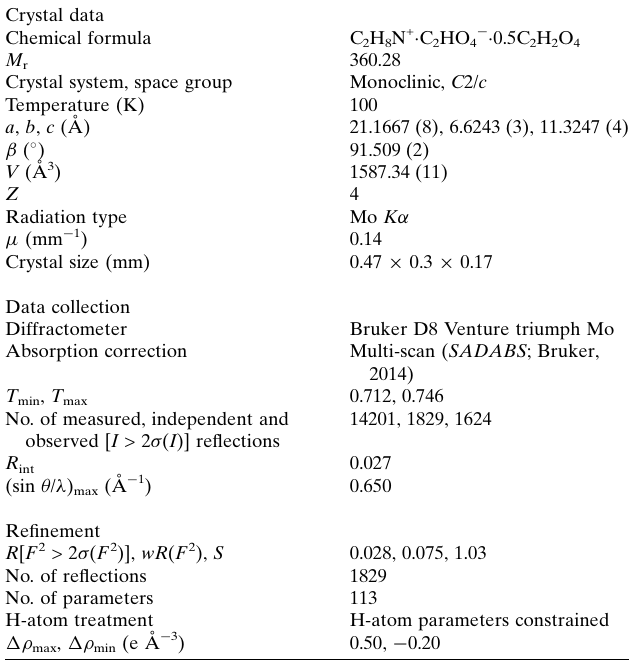
Table 1 Hydrogen-bond geometry (A˚ , (cid:5) ).